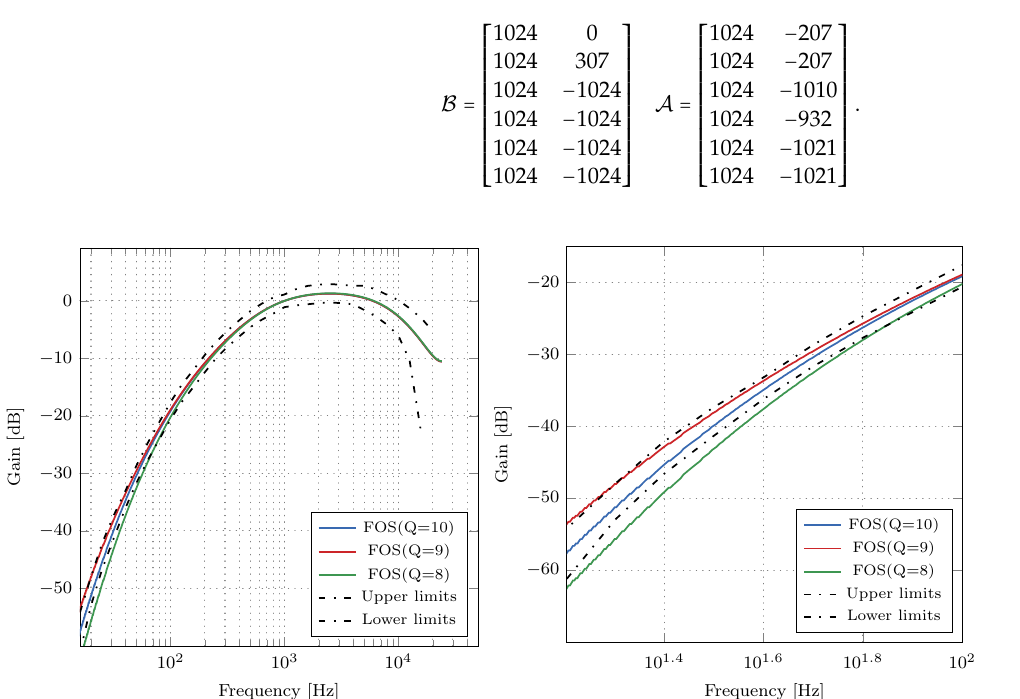
Figure 2. Magnitude responses of the digital A-weighting filter for various values of Q . Left : magnitude responses; right : enlarged portion of the magnitude responses. The filter with Q = 10 satisfies the tolerance limits for the A-weighting